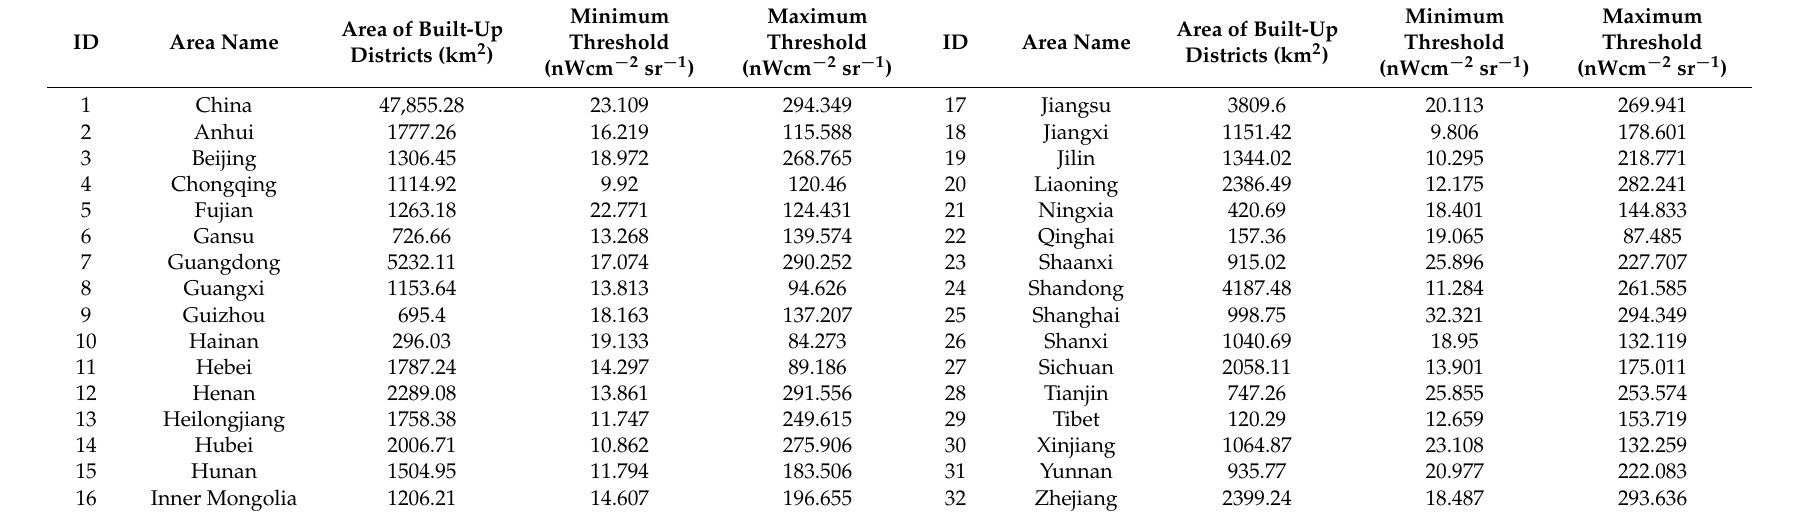
Table 1. Built-up areas and extraction thresholds. The areas of the built-up districts were from the 2013 China Statistical Yearbook. The built-up area extraction thresholds were determined by the statistical data